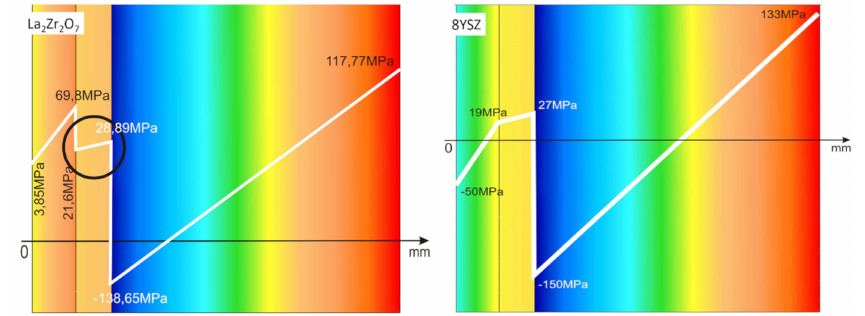
Figure 27. FEM (finite elements modelling) analysis of stress distribution in the area of La2Zr2O7 / TGO and 8YSZ / TGO